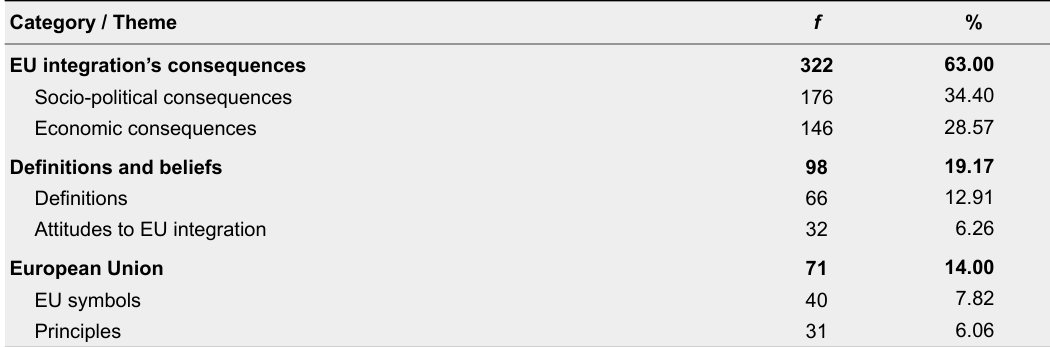
Dimensions and Themes Defining Participants’ Discourse About the European Integration (N = 511 Units of